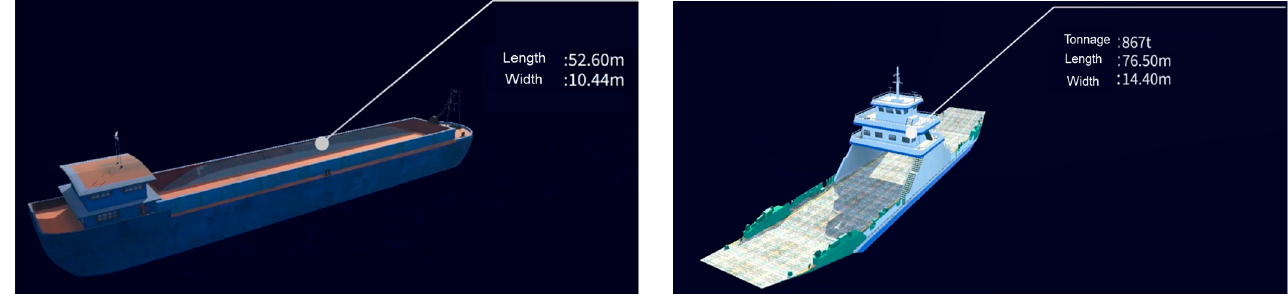
Figure 8. Inland cargo vessel and the inland target ferry for autonomous and remote-control tests.